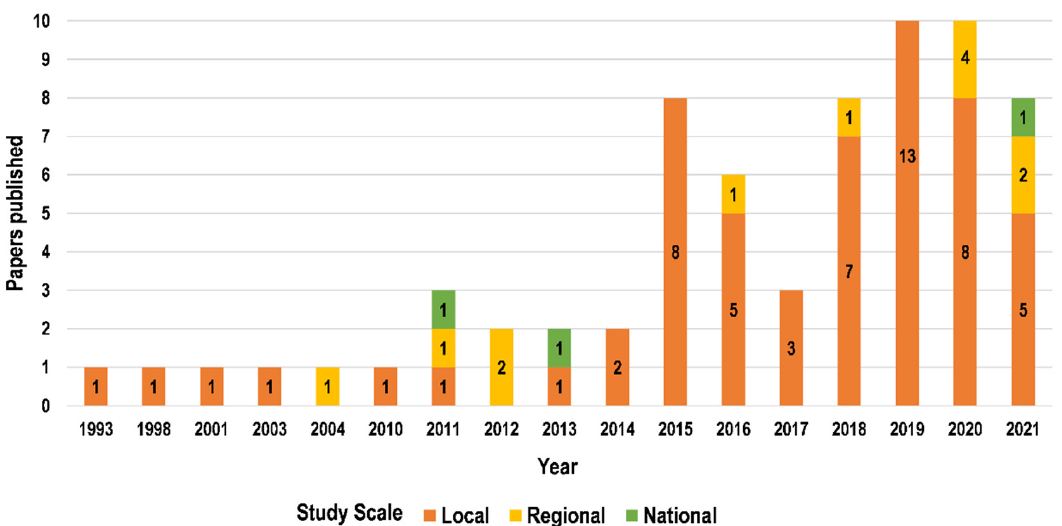
Figure 5. Distribution of study scale against each year (1993–2021).